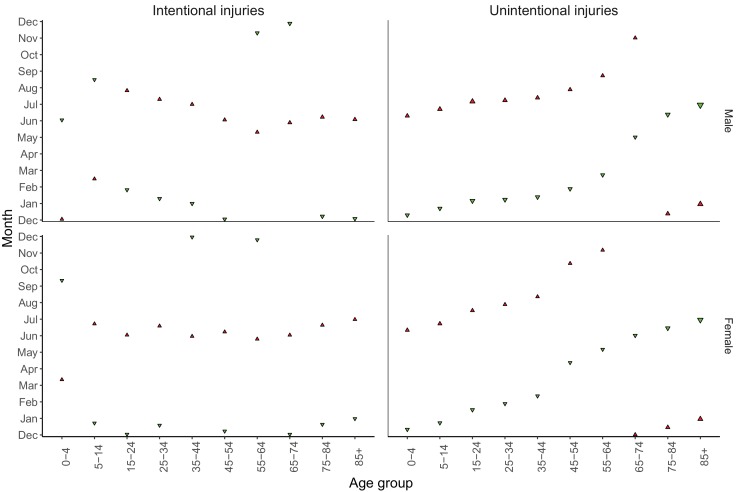
Mean timing of maximum and minimum mortality for specific injuries at the national level, by sex and age group for 1980–2016.Red arrows indicate the month of maximum mortality, and green arrows that of minimum mortality. The size of the arrow is inversely proportional to its respective variance.